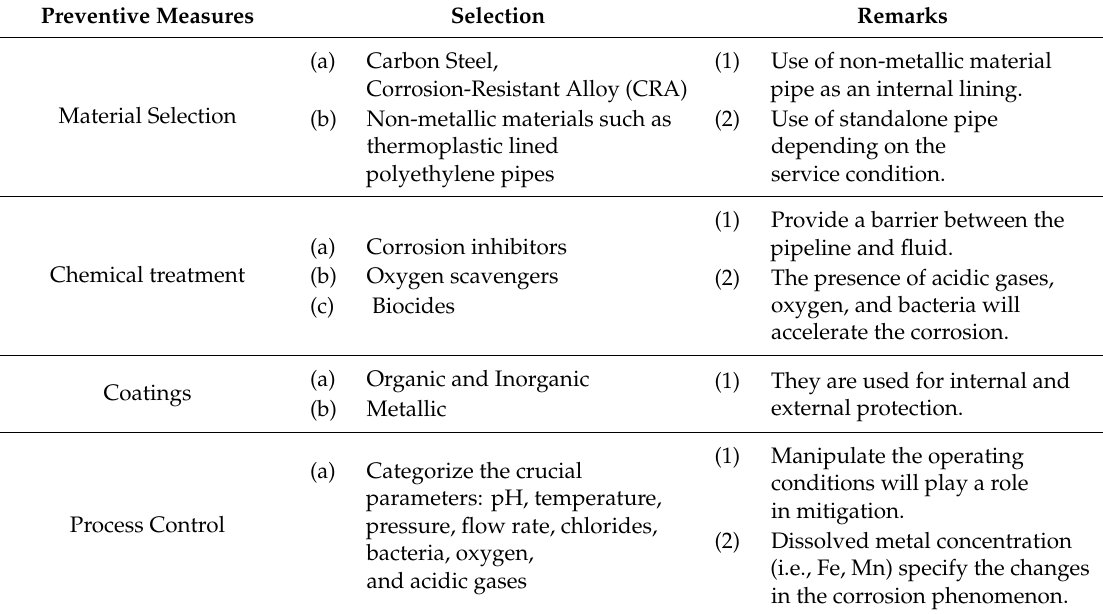
Table 1. Corrosion prevention measures